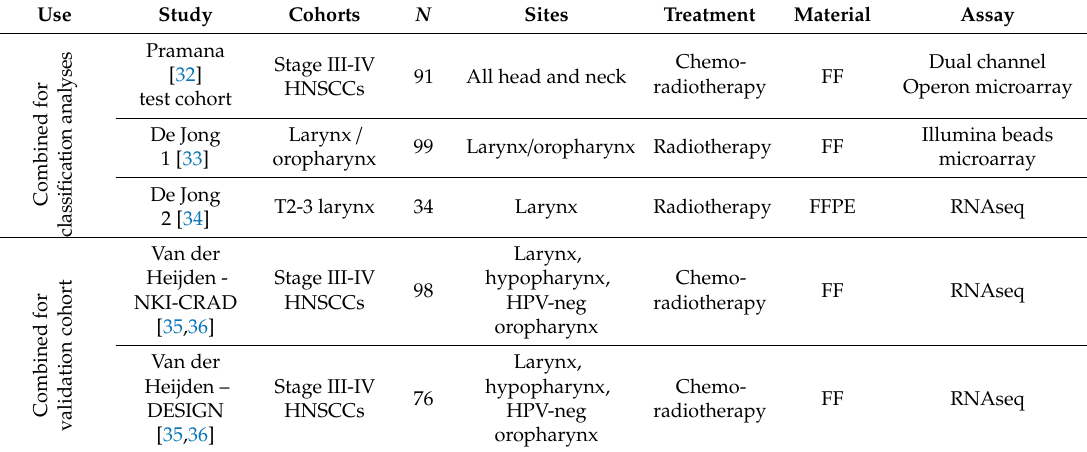
FF: Fresh-Frozen; FFPE: Formalin Fixed Para ffi n Embedded.